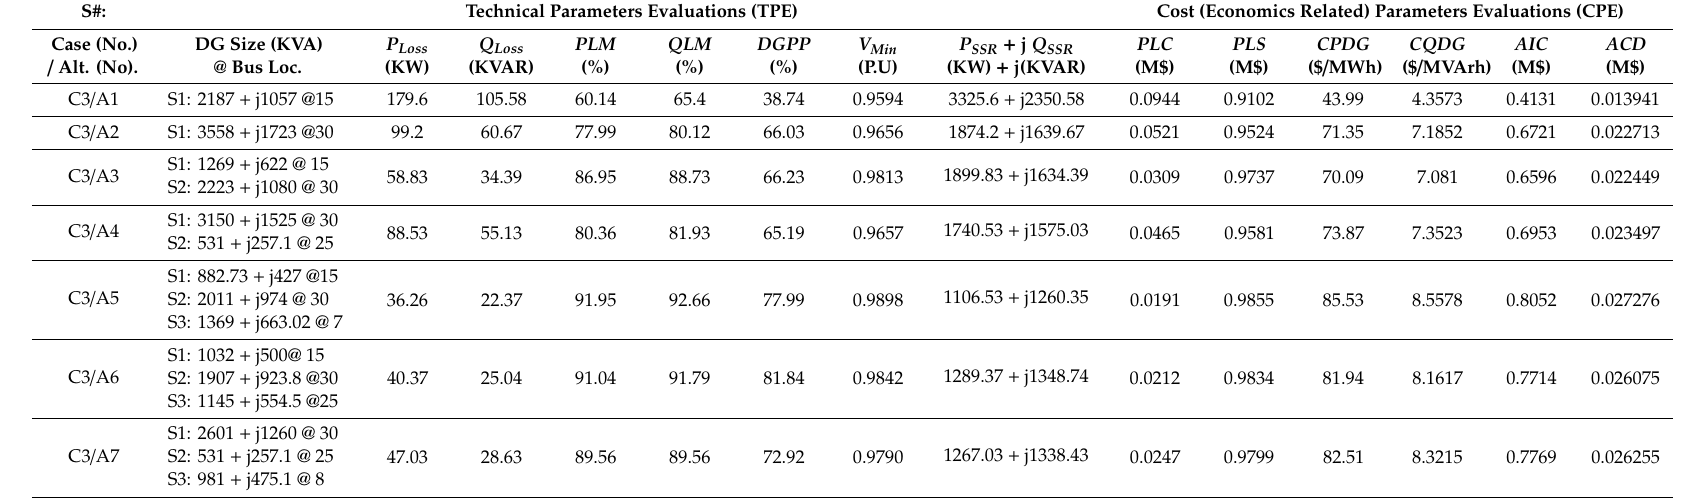
Table 25. Techno-economic evaluation analysis in case 3 (C3_OLG) for 33-bus